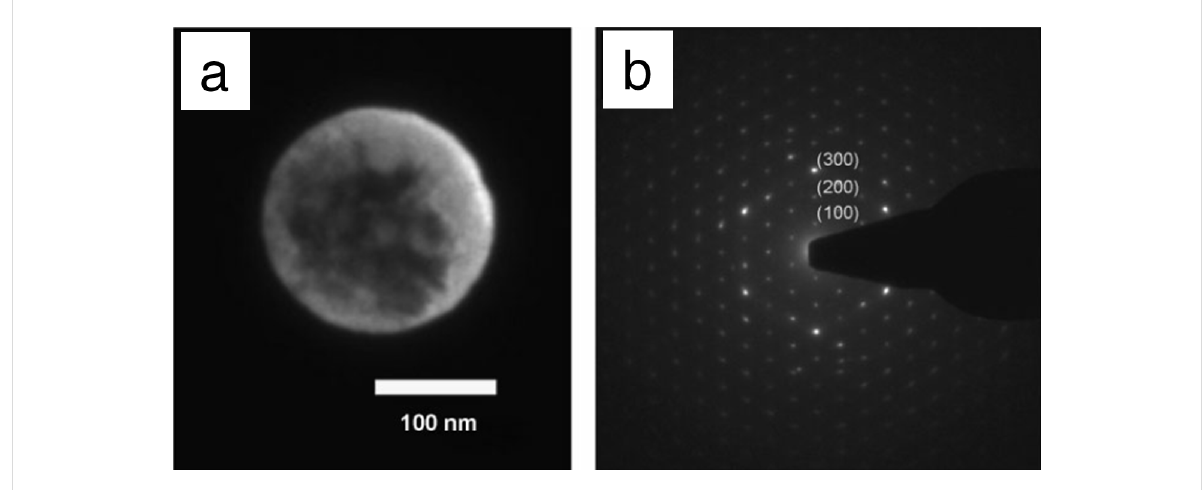
Figure 7: Dark-field TEM micrograph (a) and corresponding electron diffraction pattern (b) of hydroxyapatite/gelatin particles. Reprinted with permis- sion from [87]. Copyright 2008 John Wiley & Sons.